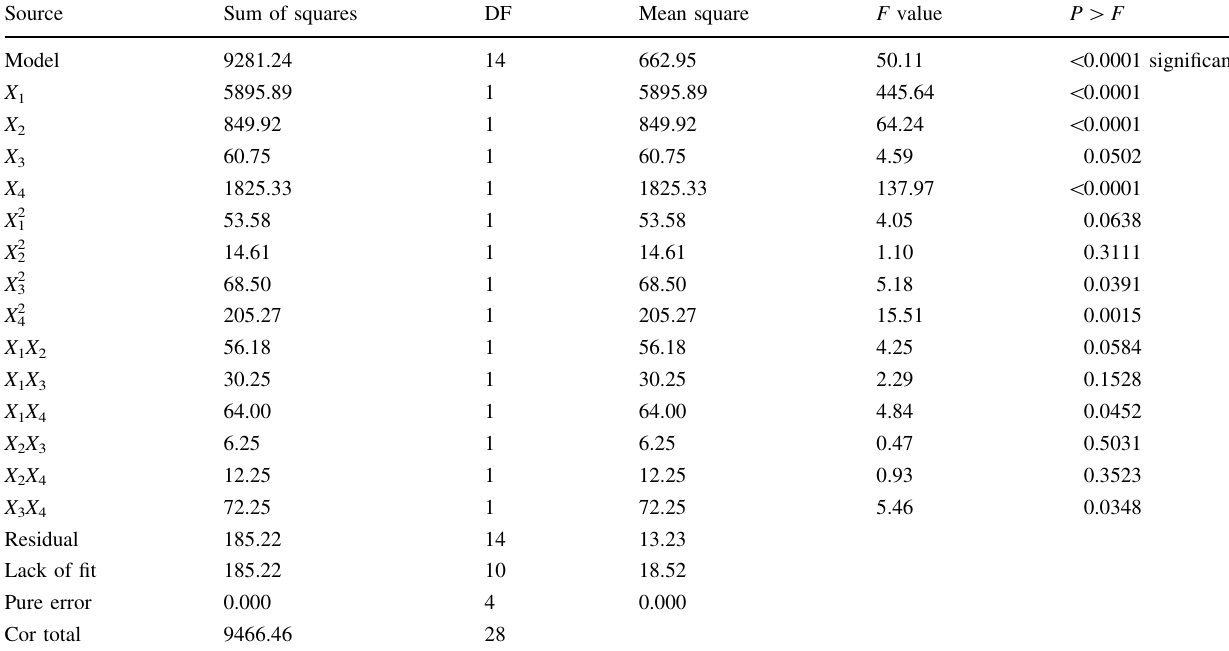
Table 8 Results of ANOVA for the percentage removal of phenol using Fe-treated tea waste biomass Source Sum of